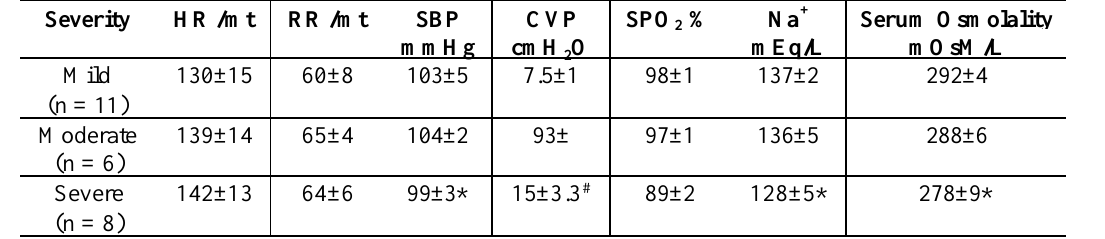
* p <0.05 as compared to mild,